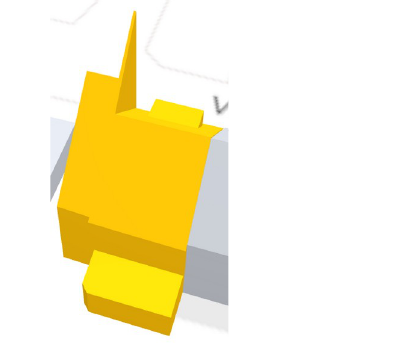
Figure 9 . An example of a model with a “screen”. This model has an RMS of 0.04 m, and a maximum model-to-point distance of 6.1 m.